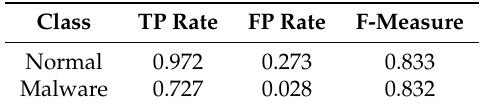
Table 15. Detailed accuracy at Stage 3 on the KDDTest + .